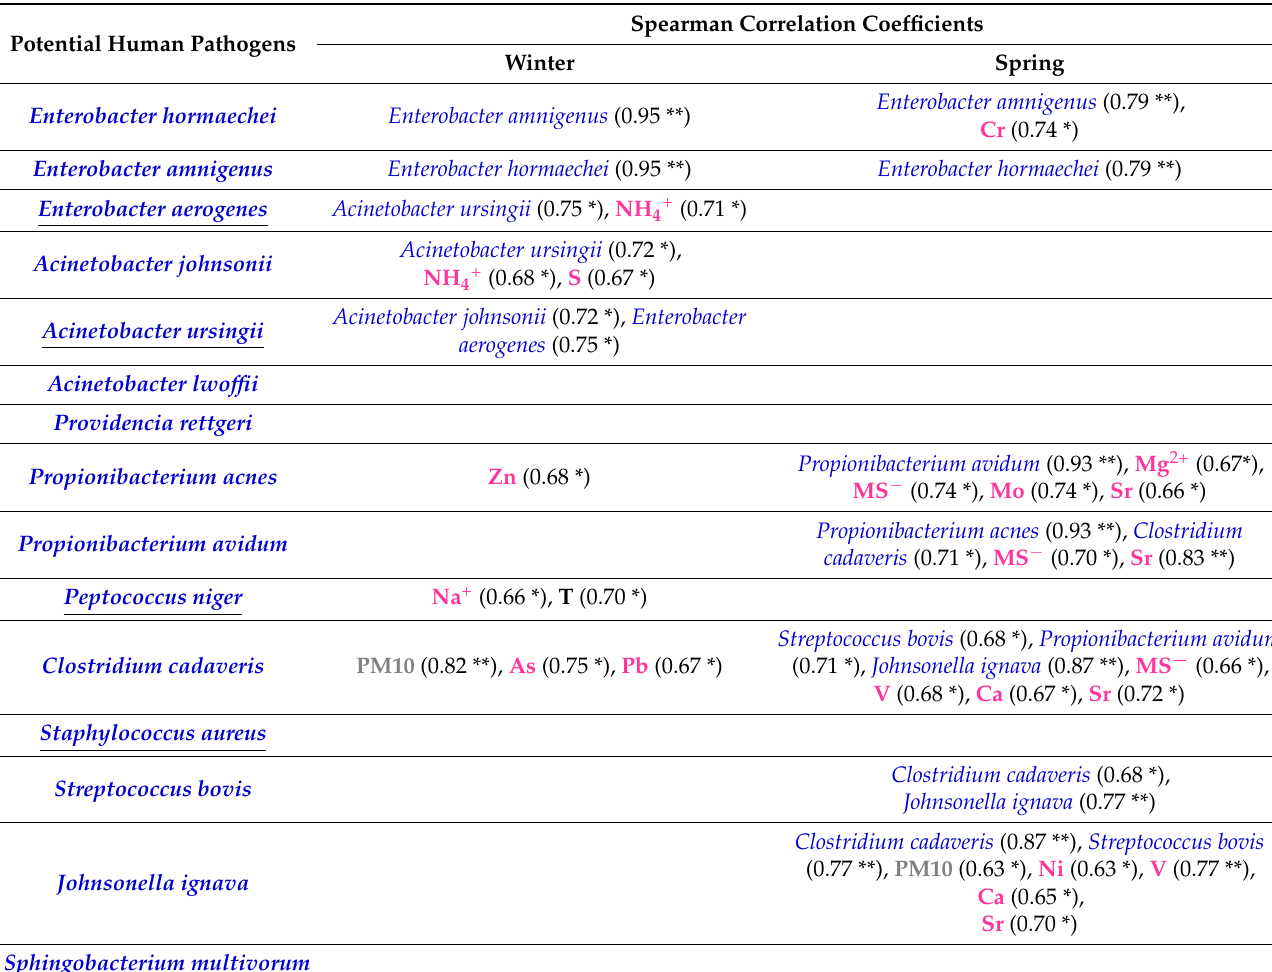
Table 1. Relationships between the 10 most abundant potential and pervasive human pathogens (blue) and with PM10 (grey) and chemical species (pink) mass concentrations, and meteorological parameters (black) in winter and spring samples. The related Spearman correlation coefficient is reported in brackets (values significant at a p -level < 0.05 and 0.01 are marked by * and **, respectively). Underlined and bold-italic species represent the ones only found in winter and spring,